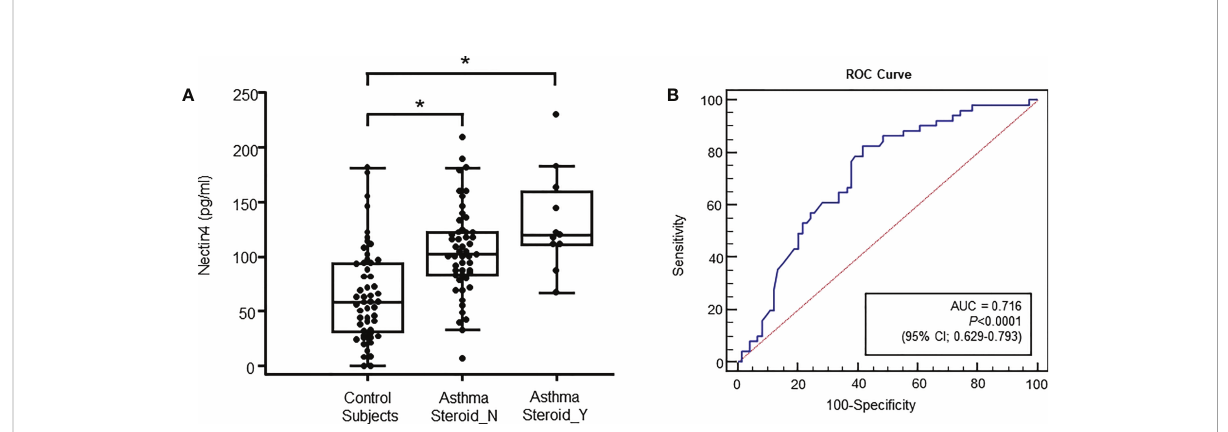
FIGURE 1 Specimens were obtained from control subjects (n = 60), subjects with non-steroid-treated asthma (n = 51), and subjects with steroid-treated asthma (n = 11) (A) Plasma Nectin4 levels in control subjects and asthma patients. *p<0.05, control vs. asthma patients. (B) Receiver operating characteristic (ROC) curves of the plasma Nectin4 levels. Nectin4 protein concentrations in asthma patients and controls (Area under the curve (AUC) =0.760, 95% CI 0.673-0.847, p<0.001). The diagonal line represents a hypothetical curve corresponding to a test affording no discriminatory power.